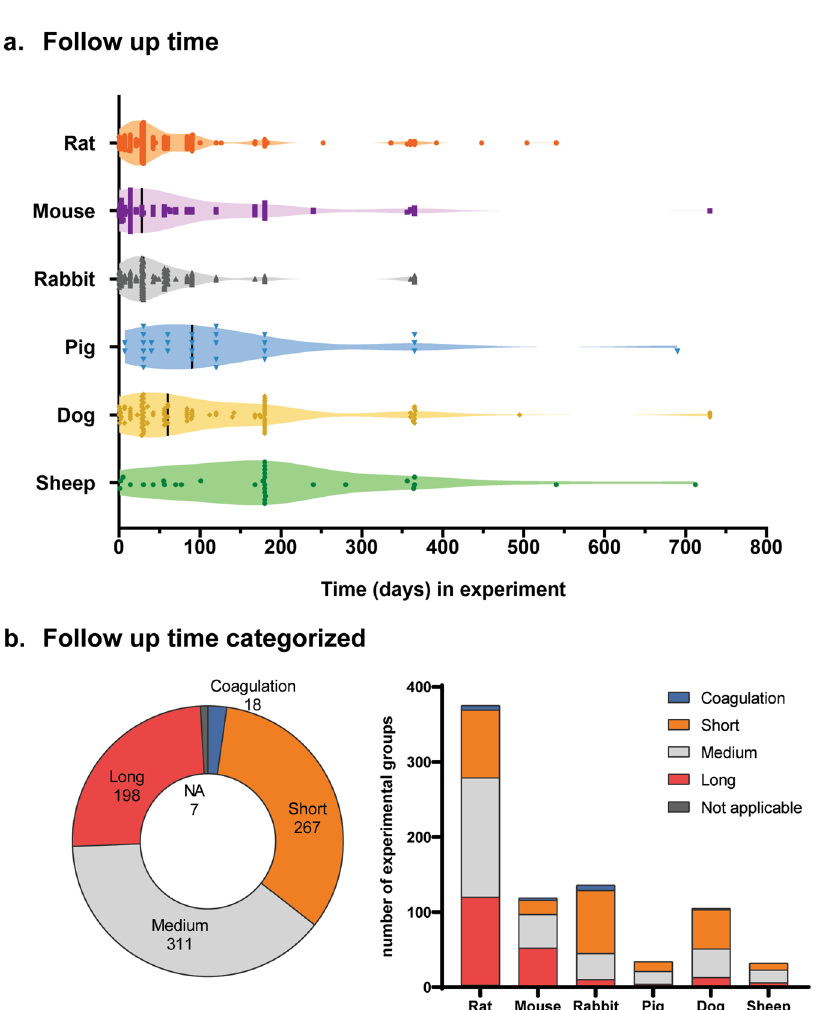
Fig. 4 Mapping of study characteristics included in the systematic review. a Follow-up time in days for all experimental groups categorized per species, black vertical line indicates average. b Follow-up time of all experimental groups and categorized per animal species according to cut-off values described in Table